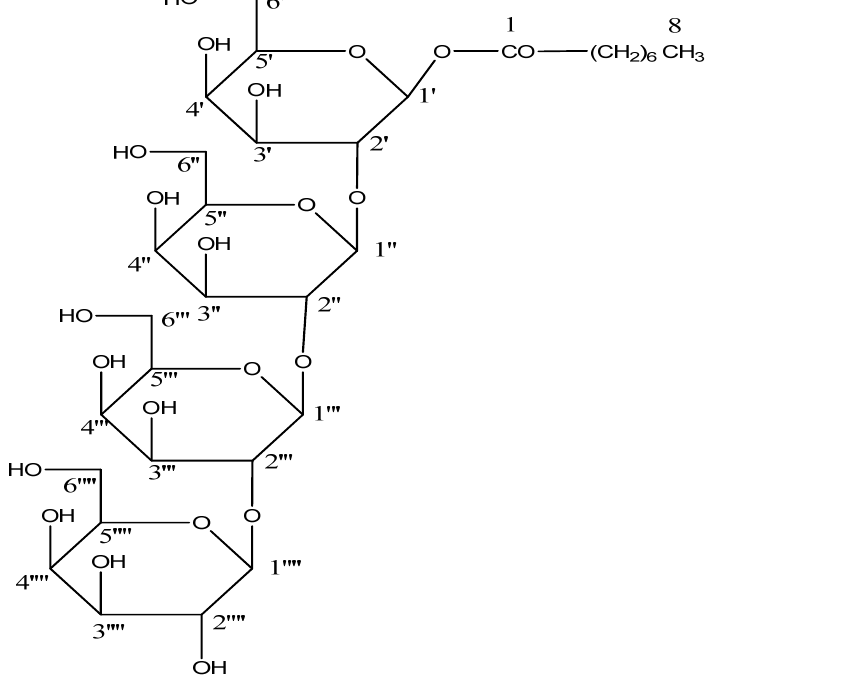
Scheme 5. Isolated compound (n-octanoyl- β -D-glucopyranosyl-(2 (cid:48) -1 (cid:48)(cid:48) )- β -D-glucopyranosyl-(2 (cid:48)(cid:48) -1 (cid:48)(cid:48)(cid:48) )- β -D-glucopyranosyl- (2 (cid:48)(cid:48)(cid:48) -1 (cid:48)(cid:48)(cid:48)(cid:48) )- β -D-glucopyranoside) Figure 1 displays the anti-inflammatory effects of isolated phytoconstituents AB-01 to AB-05 at 5 and 10 mg/kg and Indomethacin (10 mg/kg) on carrageenan-induced rat paw. When carrageenan-stimulated rats were given Indomethacin in combination with AB-01, AB-02, AB-03, AB-04, and AB-05 at a dosage of 10 mg/kg, there was a statistically significant reduction ( p < 0.05) in the volume of their paws. Compared to a higher dose of Indomethacin (10 mg/kg), the effects of AB-01 and AB-05 at 10 mg/kg were shown to be more effective in lowering the volume of the swollen paw. The aggravation is linked to the pathophysiology of different diseases, such as joint inflammation, cancerous growths, gout, and vascular diseases. In traditional clinical frameworks, various medicinal plants treat pain and inflammation signs. We found that at 5.0 and 10.0 mg/kg dosages, the AB- 01, AB-02, AB-03, AB-04, and AB-05 extracted from A. indicum extract had a calming and analgesic effect, respectively. Carrageenan acted as a phlogistic factor, increasing the syn- thesis of prostaglandins and bradykinins at certain periods [40]. All the drugs that were examined demonstrated a reduction in paw edema volume from 1 h to 5 h, and their anti-inflammatory effect was continued beyond 3 h. This analysis unequivocally showed that all examined medications may have had an effect that coop- erated with the prostaglandins surge. Curiously, the effects of AB-05 on carrageenan-in- duced paw edema were consistent throughout the 1 h and 5 h time points. Inflammatory mediators such as prostaglandins and platelet-activating factors (PAF) were triggered by carrageenan, leading to inflammation. Histamine, 5-hydroxytryptamine, and kinin all ar- rived during the first stage (0–1 h), whereas the second stage (3–5 h) was linked to the production of prostaglandin and bradykinin. Even though the 10 mg/kg dose had a greater calming effect than the 0.05 mg/kg dose, this finding was directly connected to the effects shown in carrageenan-induced paw edema, where both dosages of isolated com- pounds markedly changed the inflammatory response triggered by carrageenan [41]. The abdominal constrictions seen following the acetic acid treatment were related to the pros- taglandin-induced sensitization of nociceptive receptors in assessing analgesic potential.